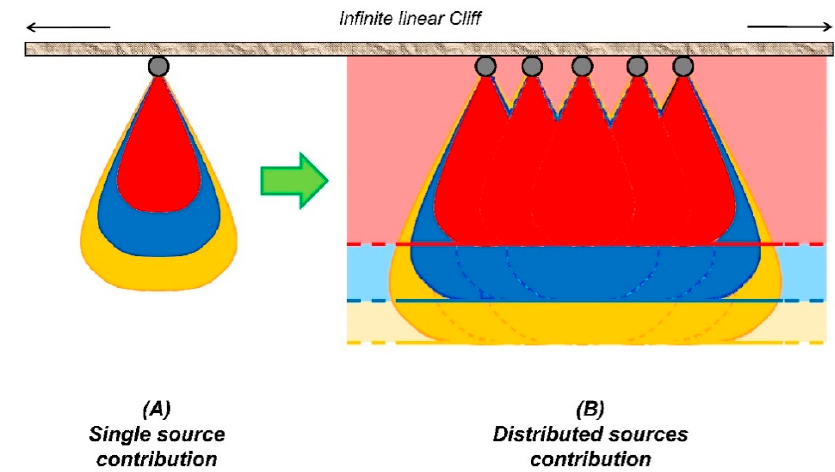
Figure 9. ( A ) Schematic shape of the hazard zoning map due to each single source. ( B ) Hazard zoning map corresponding to the combination of the hazard related to all the sources of instability located along the linear cliff.